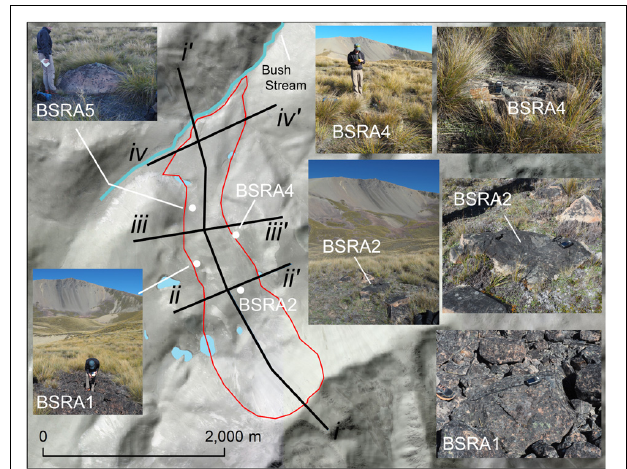
FIGURE 2 | Approximate extent of the Bush Stream Rock Avalanche (red outline; see Figure 1C ) with locations of the long-section (black line i) spanning the length of the rock avalanche and cross-sections of the deposit (black lines; proximal ii; central iii; and distal iv), and 10 Be sample locations (white dots labeled BSRA#) with corresponding photos showing sampled boulder or surrounding ground. Lakes are indicated in blue. The base image of the main map is a semi-transparent LINZ 8 m hillshaded DEM overlaid onto LINZ aerial